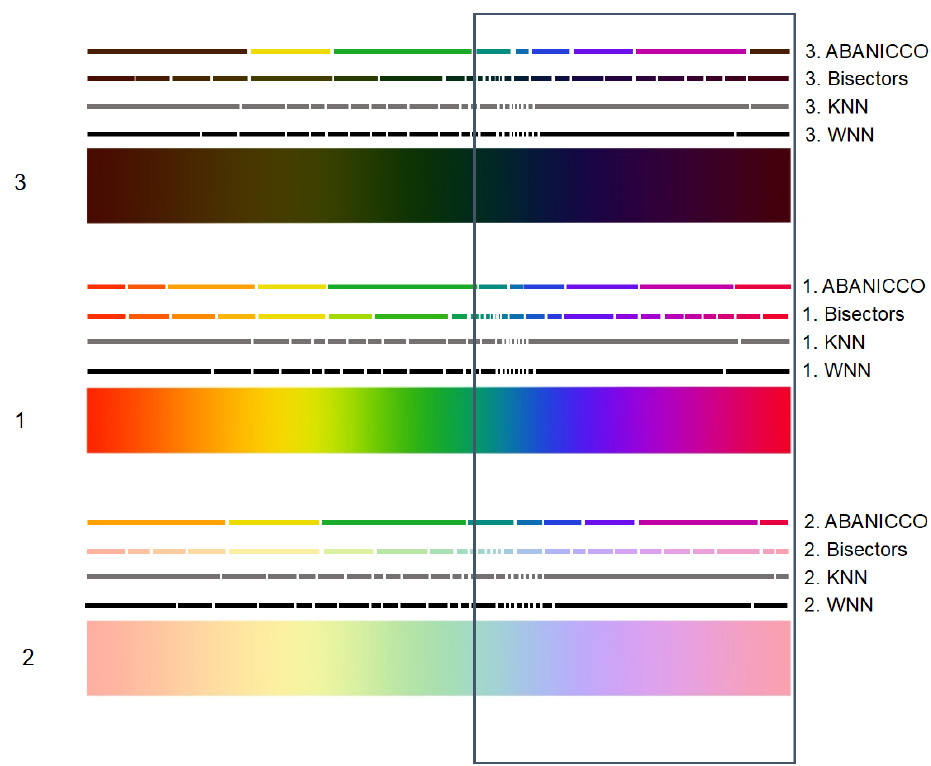
Figure A2. Segmentations obtained after using machine learning methods and the bisector approach to find the boundaries between the color bases. This evaluation was carried out in three rectangles depicting the concept of color wheel shadows and tones. Rectangle 1 shows the full-color wheel. Rectangle 3 above was obtained by adding 75% of black to represent shades. Rectangle 2 below was obtained by adding 75% of gray to represent tones. Above each rectangle are lines measuring the length of the classes obtained by each method. The solid gray lines represent the classification carried out by wKNN. The solid black lines represent the classification by WNN. The color lines represent the classification by our method, with just the bisectors and, above, the simplified final ABANICCO classes. The black rectangle marks the area used for the evaluation in Figure